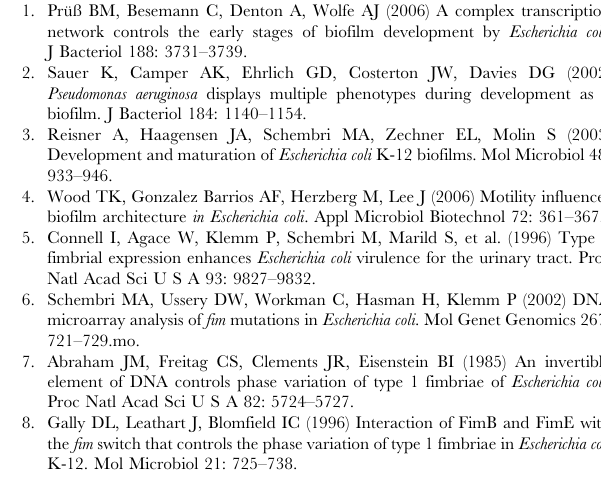
Table S4 Rare codons present in E. coli fim genes. The numbers in bold indicate more rare codons than expected according the E. coli codon usage for the complete genome. The expected use of